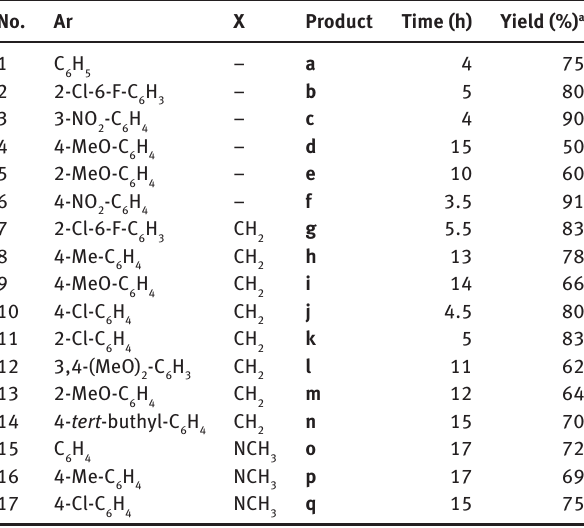
Table 3: Synthesis of 4 H -pyran derivatives.